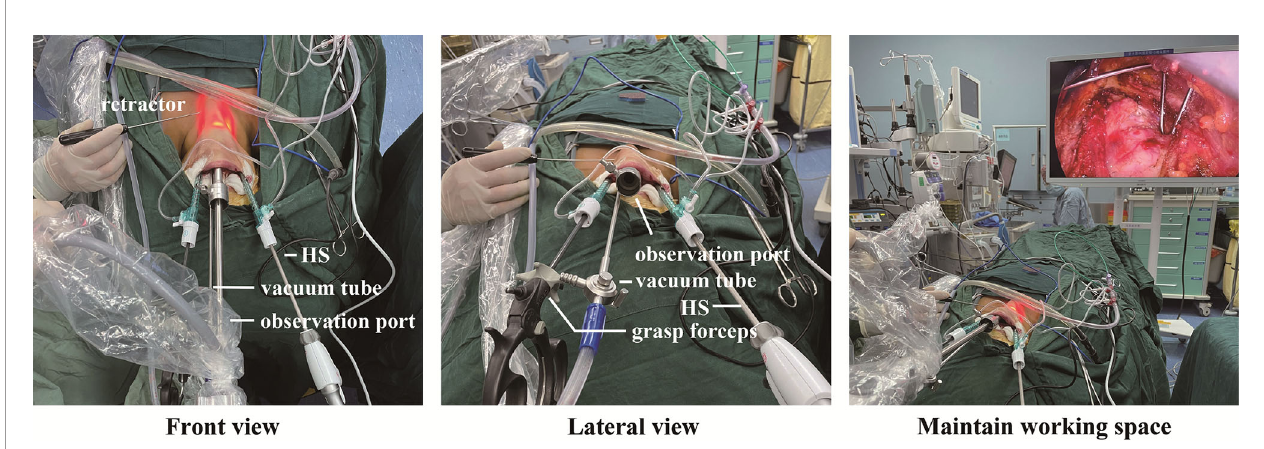
FIGURE 3 | Introduce another vacuum tube for working space building in TOETVA.